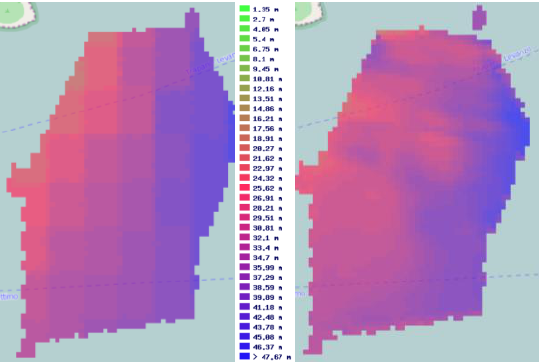
Figure 4. Levanzo island, Sicily. Reference Bathymetry (100x100m) on the left and SAR Computed Bathymetry (25x25m) on the right